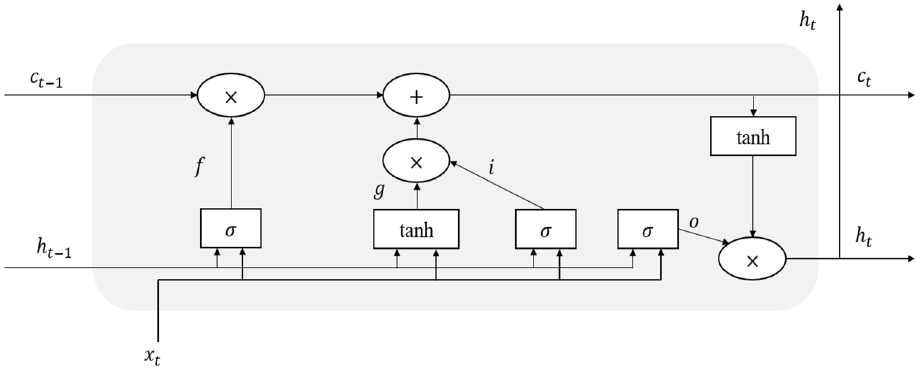
Figure 7. Structure of Long Short-Term Memory (LSTM).